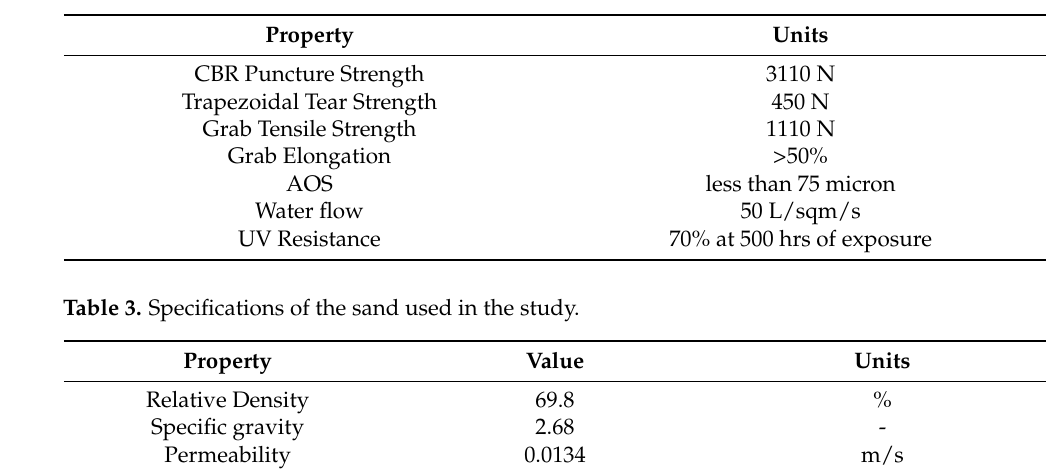
Table 2. Specifications of the non-woven needle-punched geotextile.